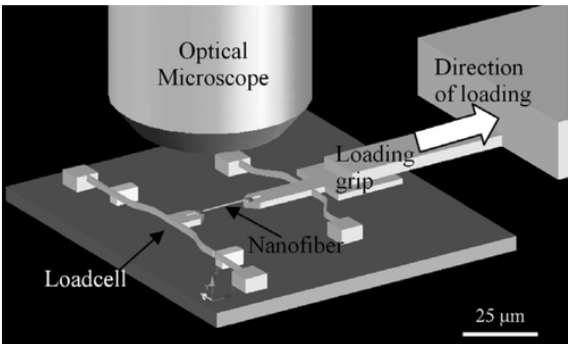
Figure 13. Microtensile testing platform for determining the mechanical characteristics’ single-electrospun nanofiber. Reprinted from [120] with permission from AIP Publishing .